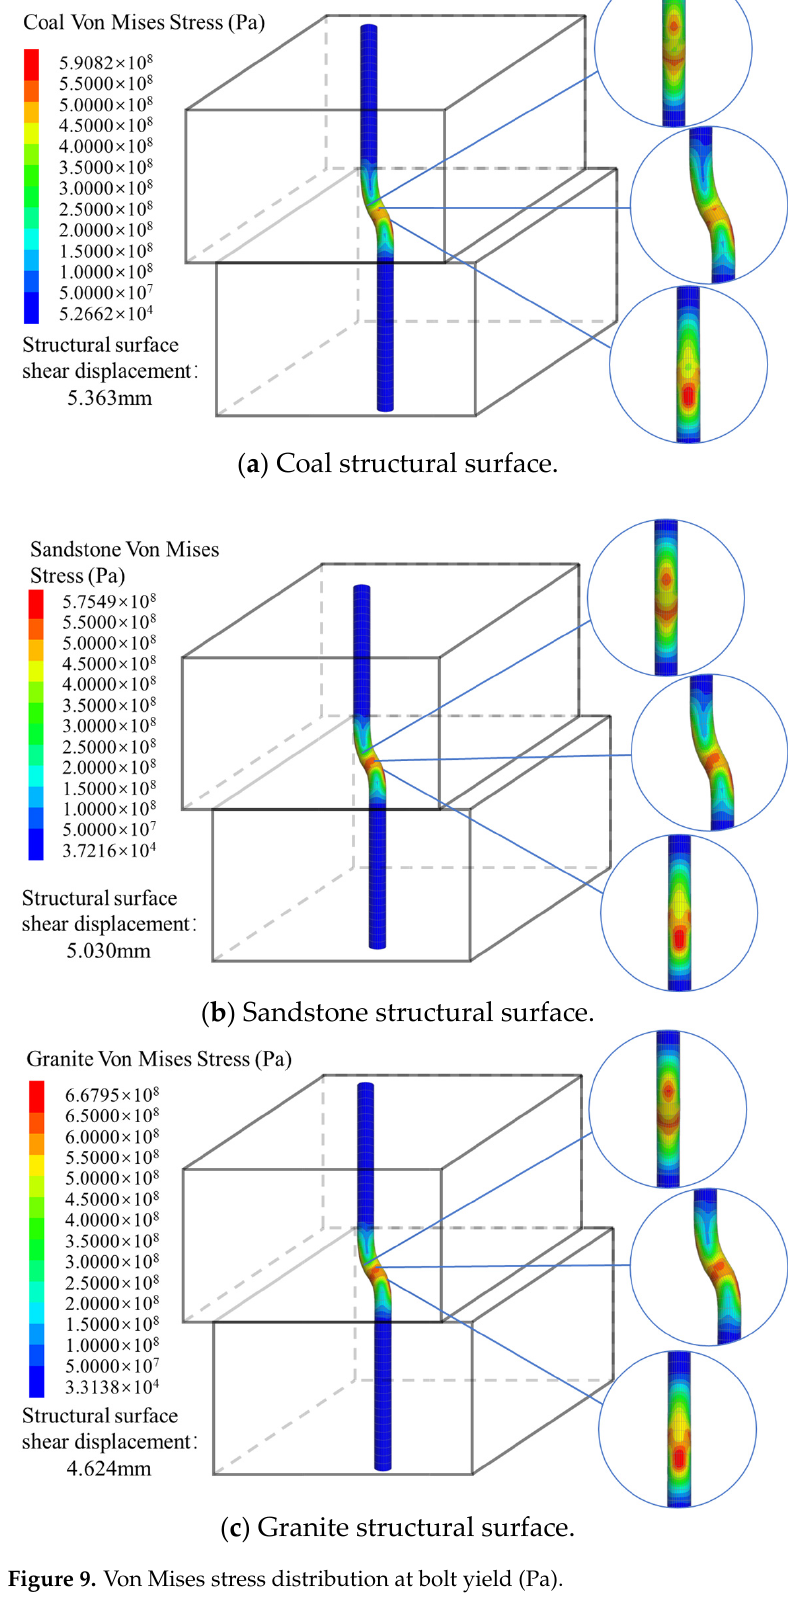
Figure 9. Von Mises stress distribution at bolt yield (Pa).